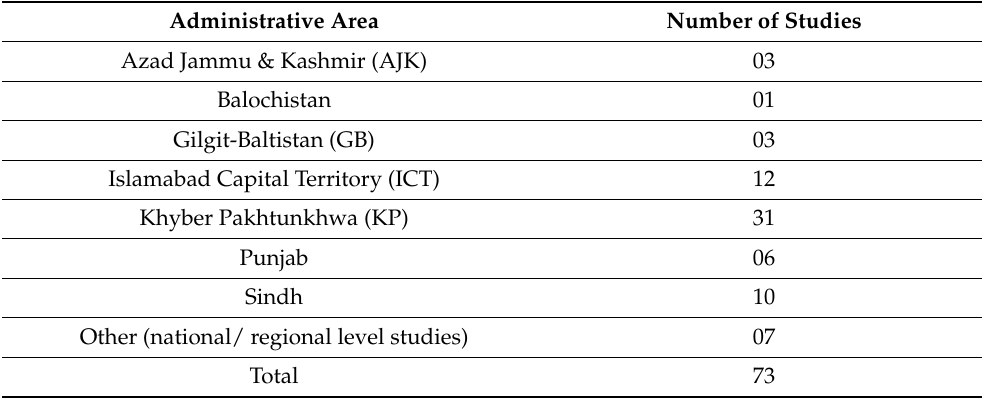
Table 1. Number of studies published in each administrative division of Pakistan